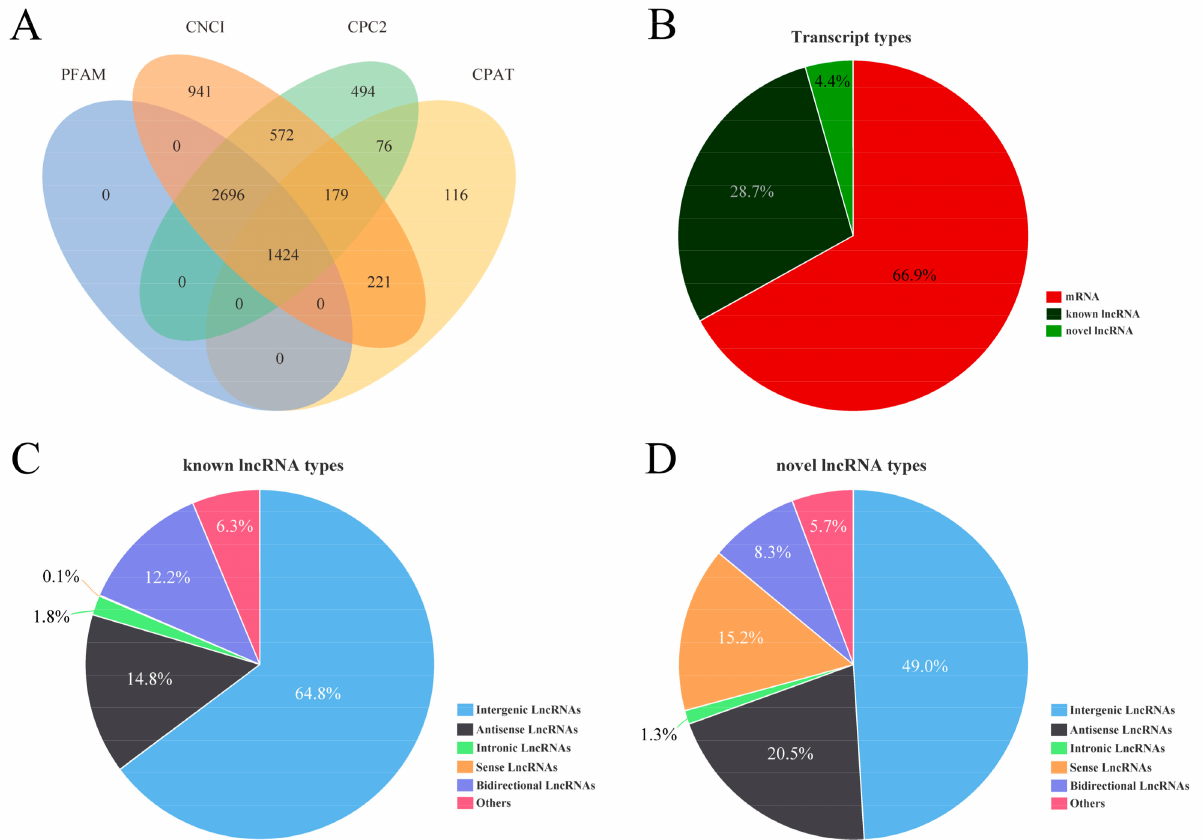
Figure 2. ( A ) Identification of 1424 putative lncRNAs without protein-coding potential evaluated by CNCI, PFAM, CPC2, and CPAT; ( B ) classification of transcripts; ( C ) known lncRNAs; ( D ) novel